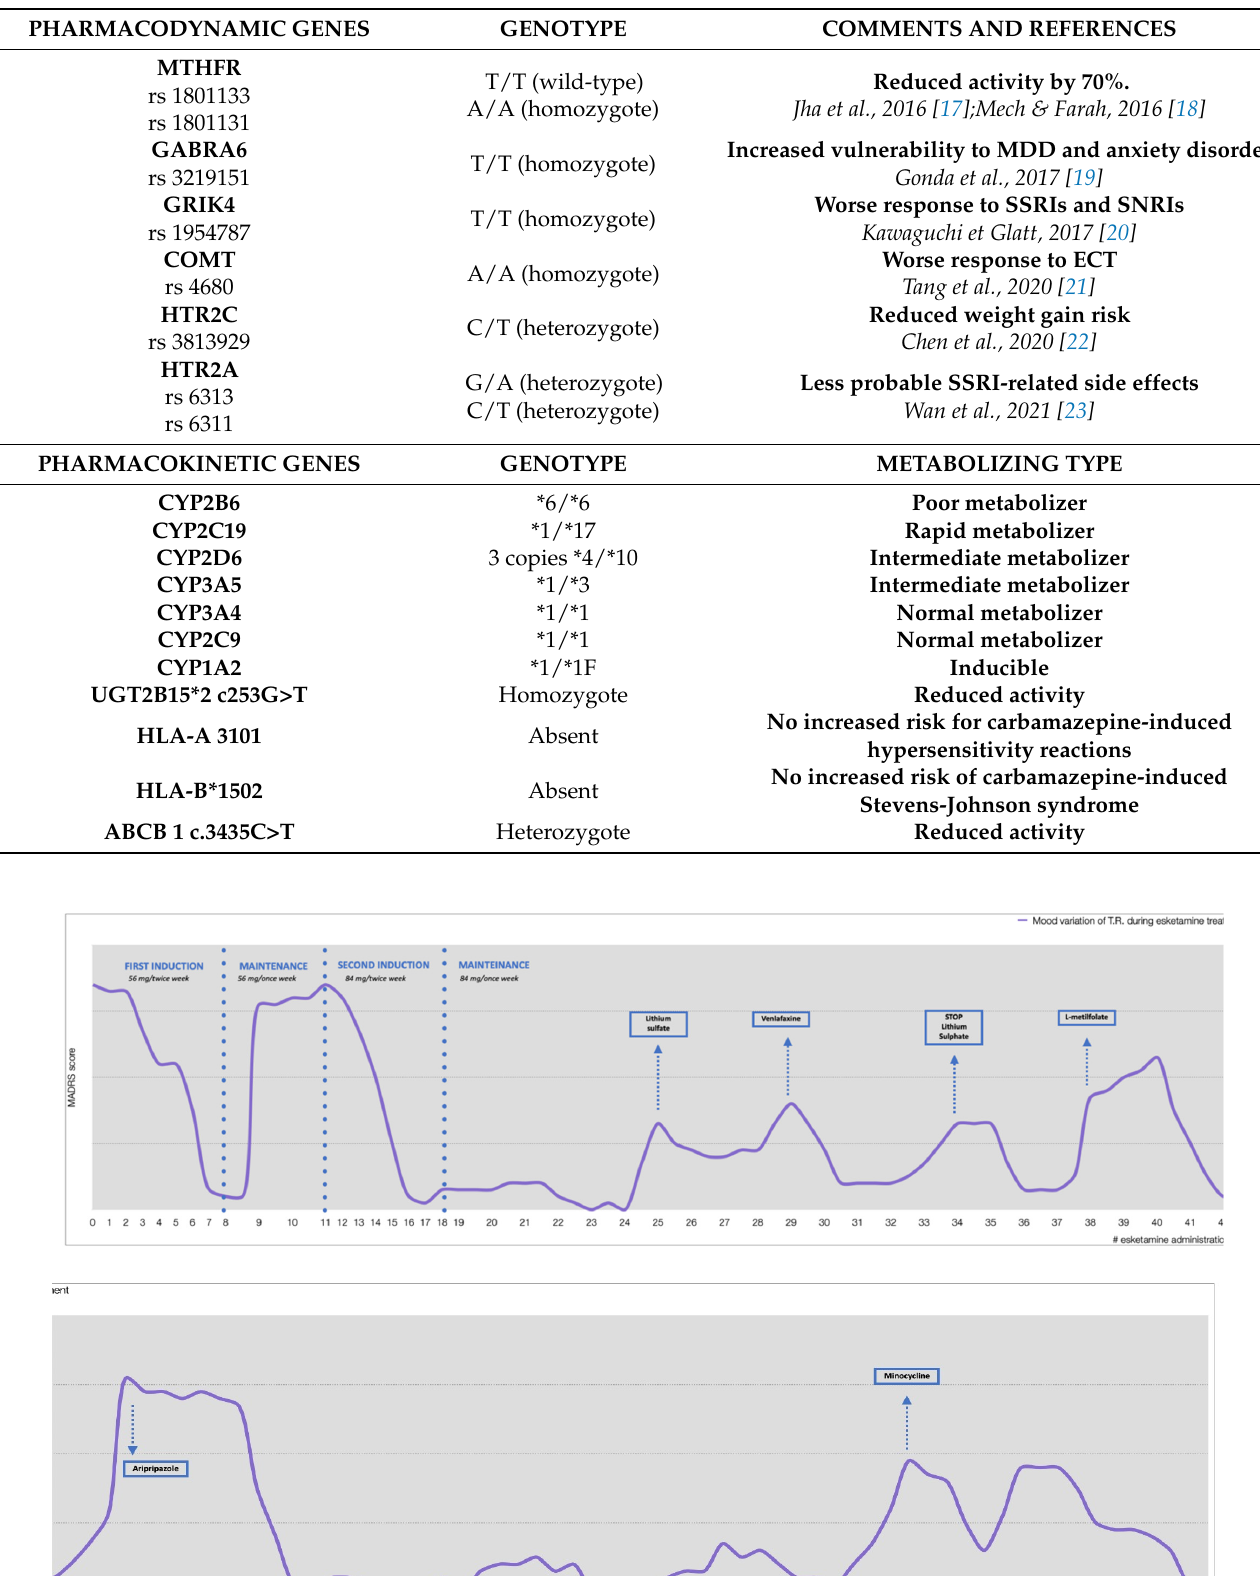
Table 4. Pharmacogenetic analysis.